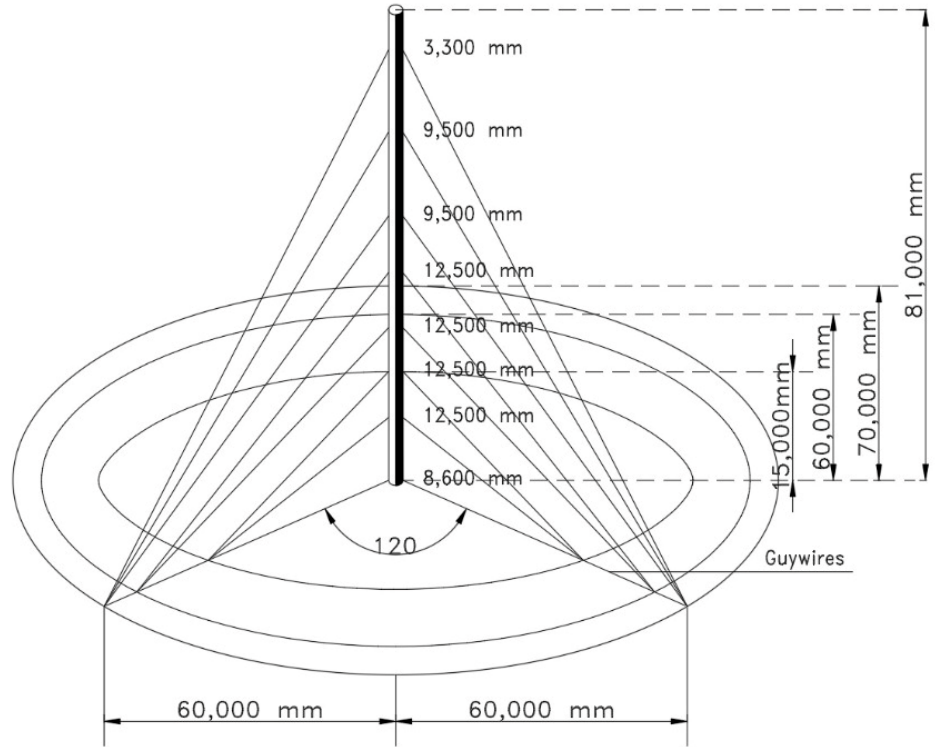
Figure 15. GFRP guyed tower, adapted from Ref. [53].